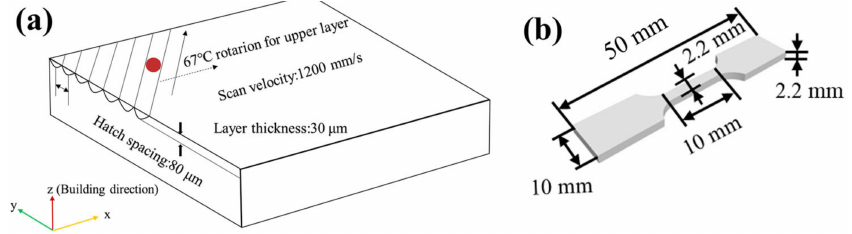
Figure 1. Schematic diagrams of ( a ) cubic specimen and ( b ) tensile